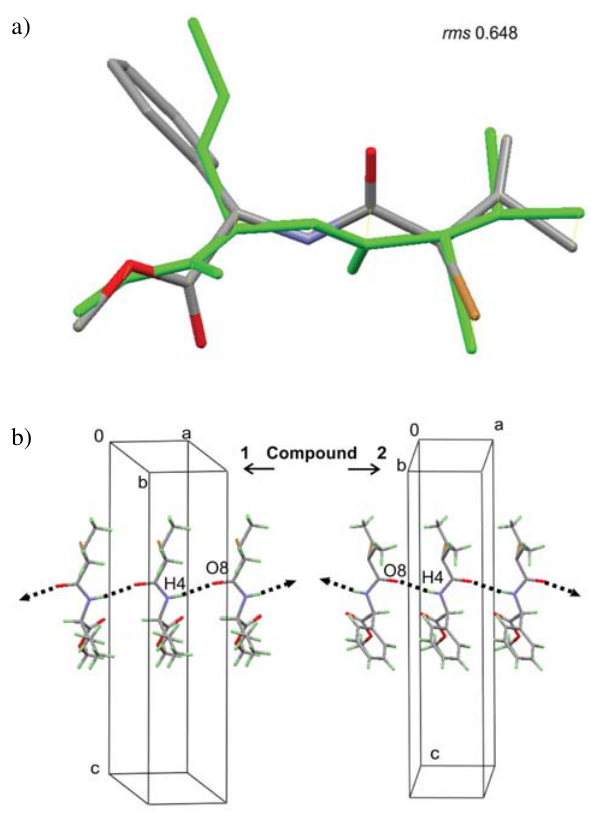
Figure 2. ORTEP view of compounds 1 (a) and 2 (b) with the ato- mic numbering scheme; ellipsoids are drawn at 40% probability, hydrogen atoms are shown as small spheres of arbitrary radii. Only the principal disorder component (C11A, C12A, C13A, Br9A) is represented.